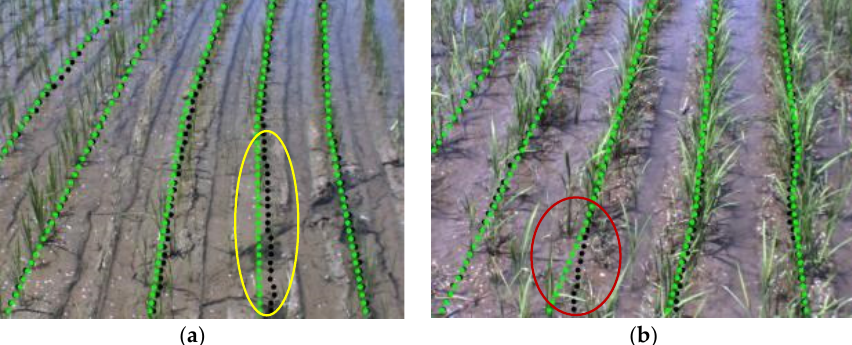
Figure 10. Examples of wrong predictions in two environments: ( a ) Lack of seedlings; ( b ) Weeds; The yellow circles represent where the rice rows are sparsely distributed; The red circle represents the place covered by weeds.